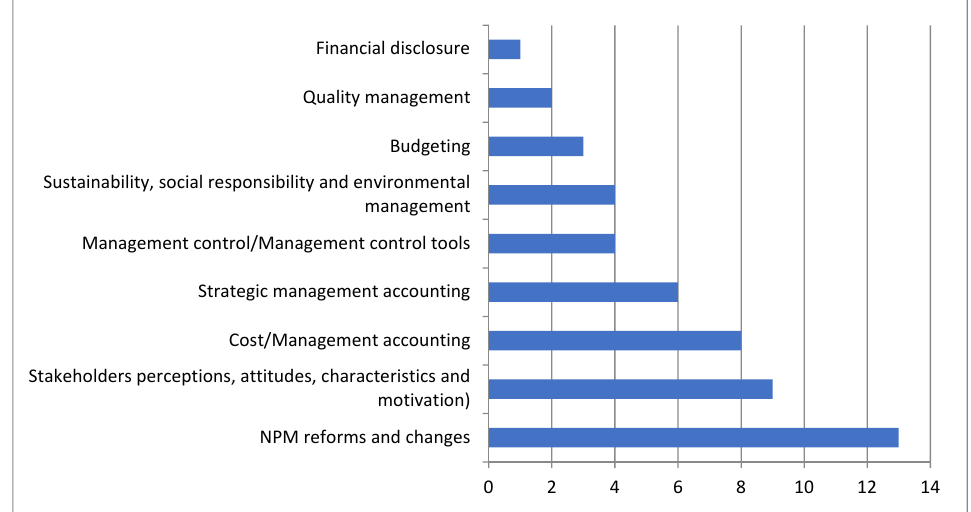
Figure 4. Number of articles per category.